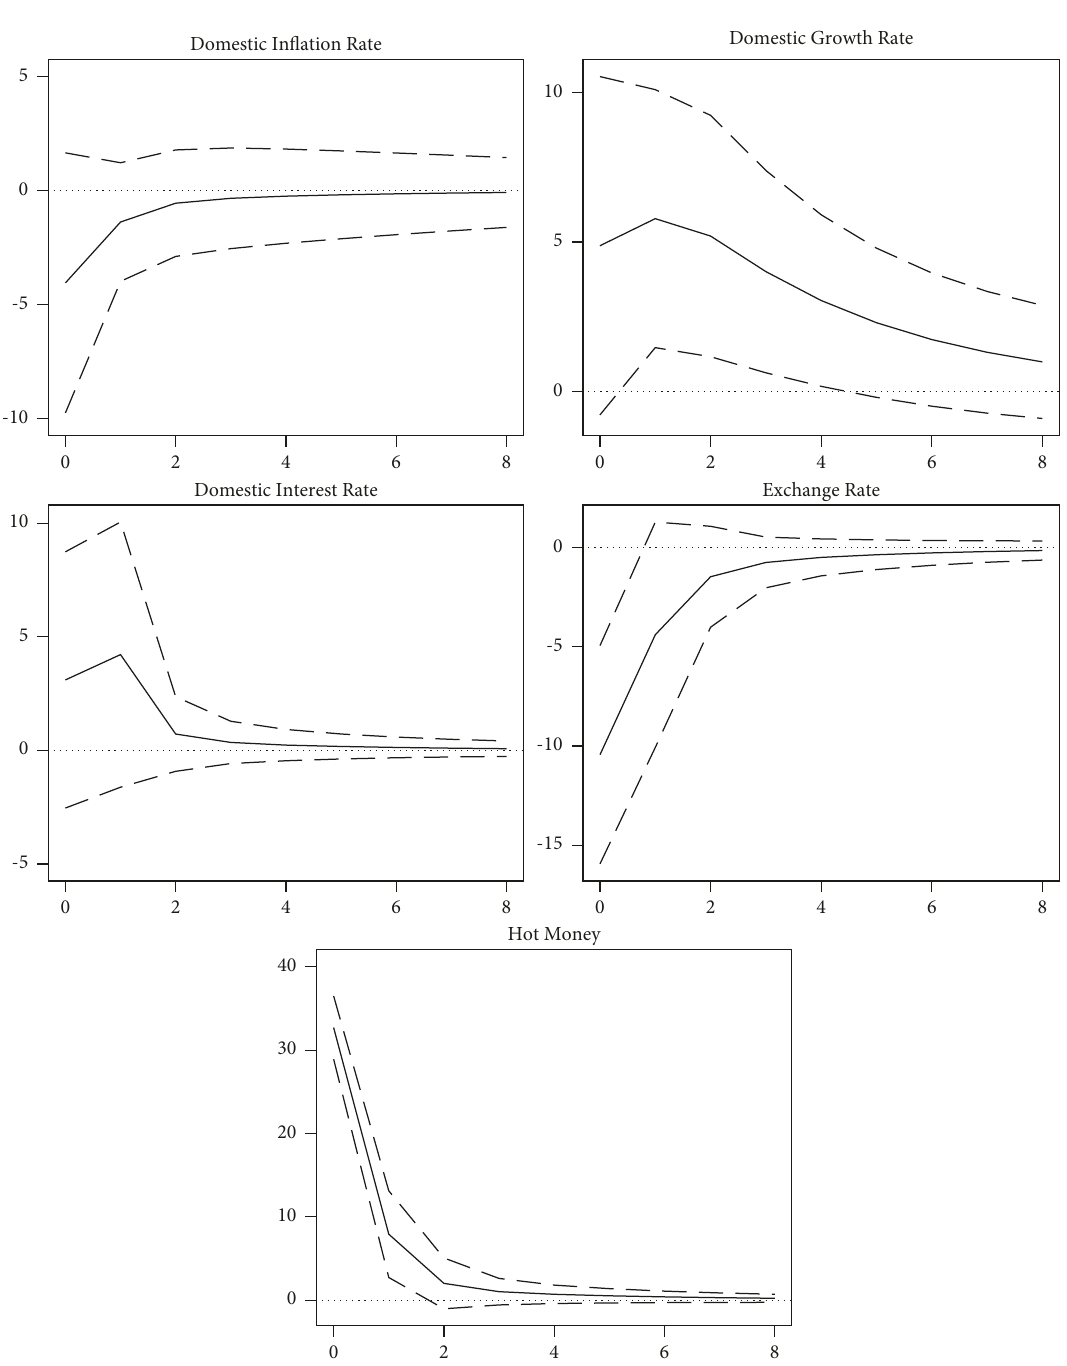
Figure 3: Impulse response functions of SVAR (postcrisis